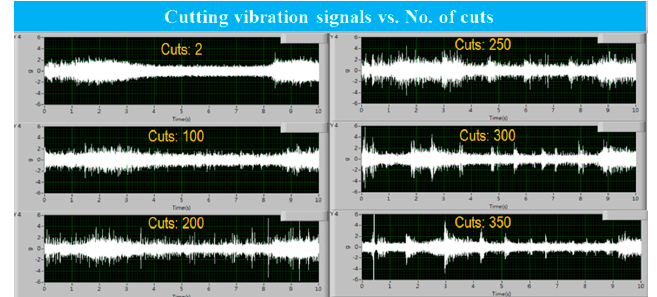
Figure 8. Cutting vibration vs . number of cuts for machining process T04.